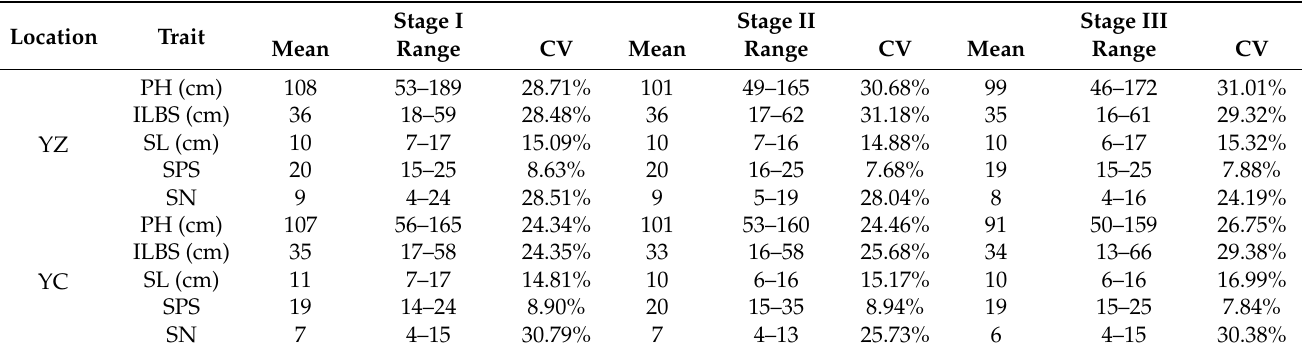
Table 1. Performance of various traits under different locations and sowing